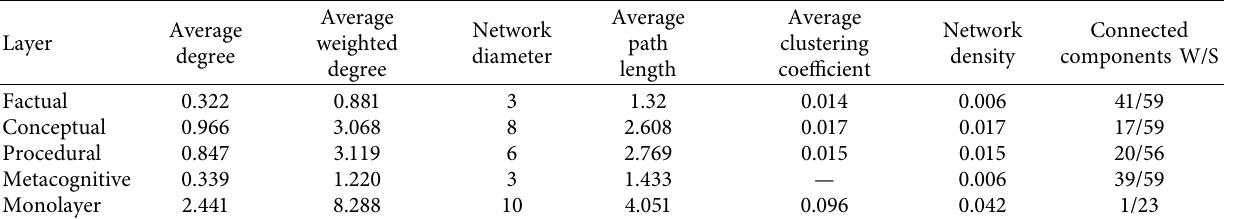
Figure 2: Network representation of four projected layers in a multidimensional knowledge network (MKN) for the learning outcomes of the database Table 1: Values of average degree, average weighted degree, network diameter, average path length, average clustering coefficient, graph density and the number of connected components W/S (weakly/strongly) for the projection layers of ip ( M ) and mp ( M ) .